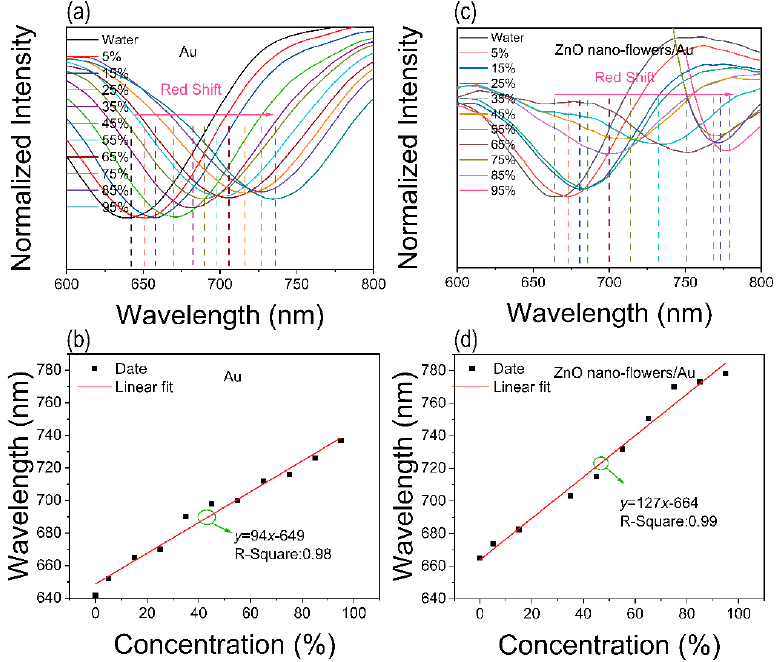
Figure 5. Schematic diagram of alcohol sensing performance. ( a ) SPR signal of the device with Au film against different alcohol concentrations. ( b ) Linear fit of the device with Au films against different alcohol concentrations. ( c ) SPR signal of the device with ZnO nanoflowers/Au structure against different alcohol concentrations. ( d ) Linear fit of the device with ZnO nanoflowers/Au structure against different alcohol concentrations.